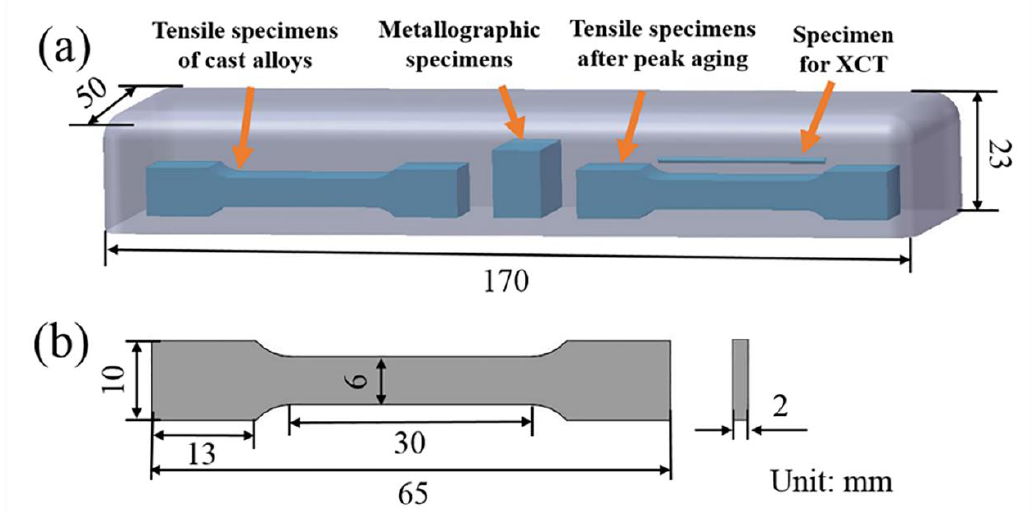
Figure 2. ( a ) Casting size and sampling location; ( b ) Tensile specimen shape and size.